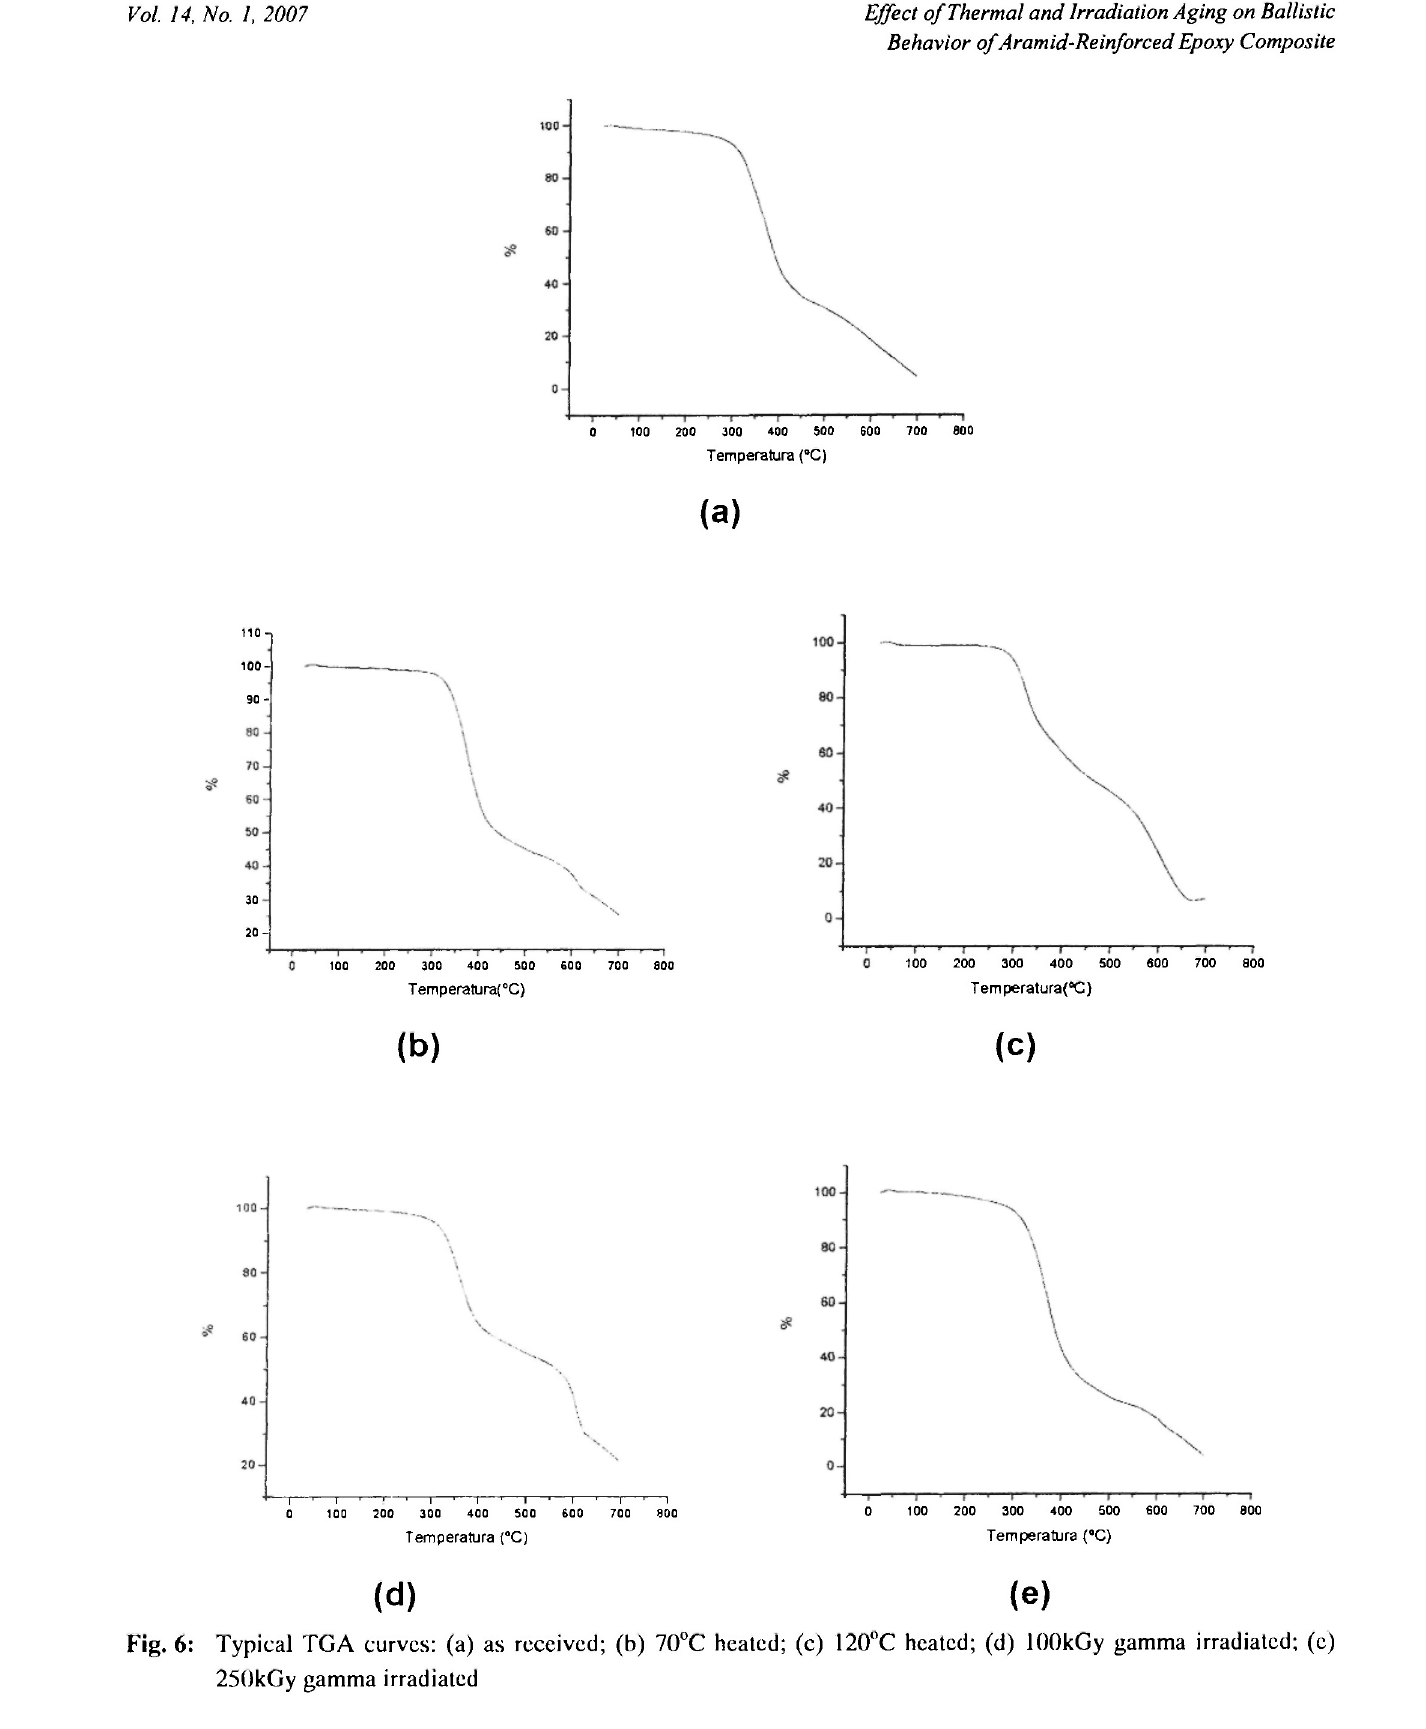
Typical TGA curves: (a) as received; (b) 70°C heated; (c) 120°C heated; (d) lOOkGy gamma irradiated;